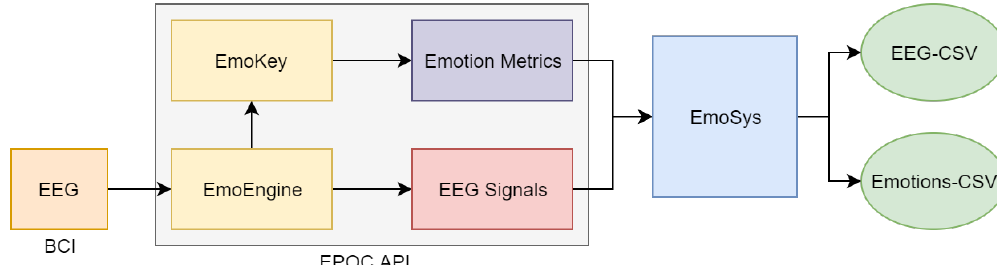
Figure 2. Acquisition system using the headset, its application programming interface (API) and EmoSys. Electroencephalography (EEG), brain-computer interface (BCI), comma-separated values